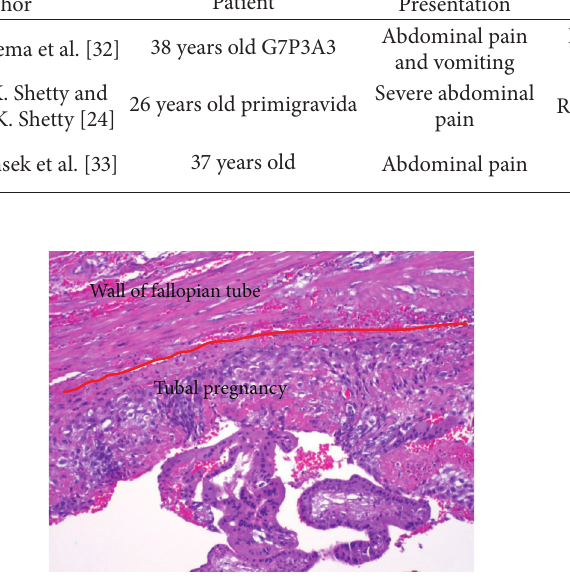
Figure 5: Pathology for patient 2. Specimen 2: left tubal ectopic pregnancy from laparoscopy. Tubal pregnancy: slide from fallopian tube, showing the wall of fallopian tube and a tubal pregnancy with decidua, chorionic villi, and syncytiotrophoblast inside the fallopian tube, confirming the ectopic pregnancy in the fallopian tube and therefore heterotopic